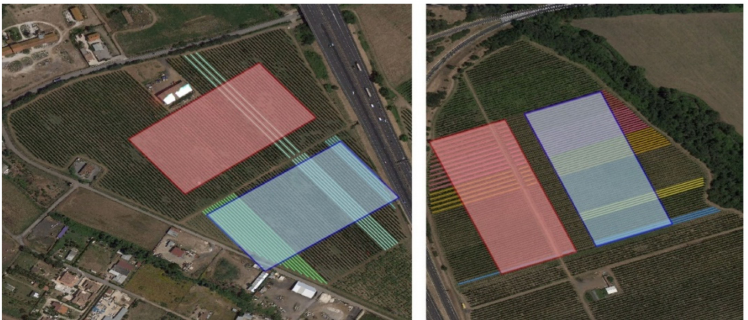
Figure 6. Example of maps showing the treatments performed in block A (on the left) and block B (on the right) after the DSS recommendation of July 14 for block A and August 4 for block B (see Figure 5). The coloured rows represent the path of the tractor in the field for both DSS-assisted (red area) and conventional (blue area) plots. Rows with di ff erent colours represent various treated cultivars. Background image from Google Earth.